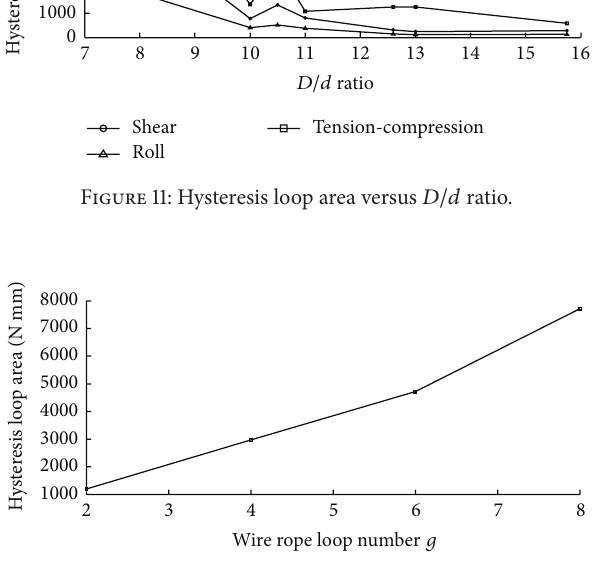
Figure 12: Hysteresis loop area versus the number of the wire rope loops.